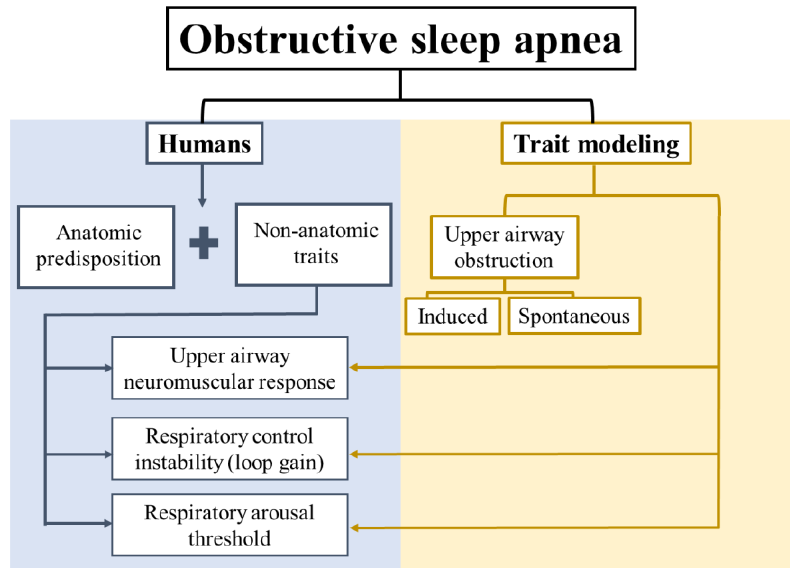
Figure 1. Schematic representation of the anatomical and non-anatomical traits of obstructive sleep apnea (OSA) pathophysiology in humans, and a general classification of OSA traits modeling.